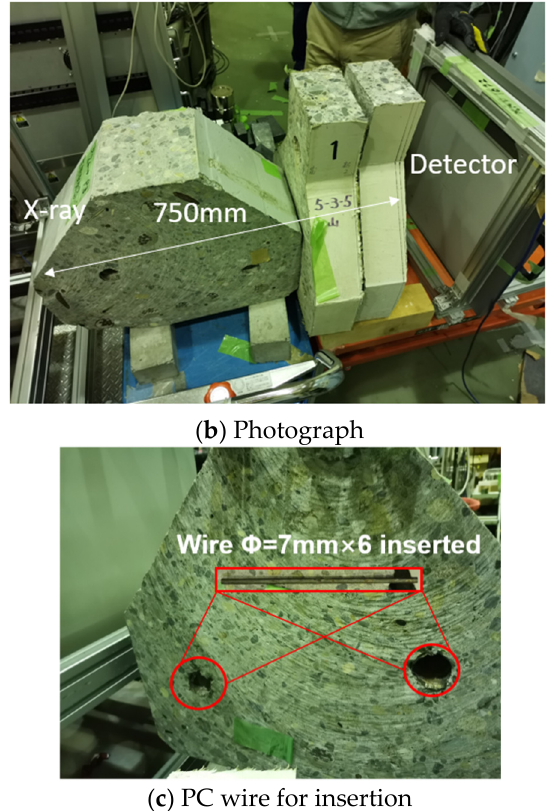
Figure 29. Experimental configuration ( a ) and photograph ( b ) for modeling the 750 mm thick side WEB wall of a box-shape PC girder bridge with the 3.95 MeV X-ray source and FPD. ( c ) PC wire for insertion.